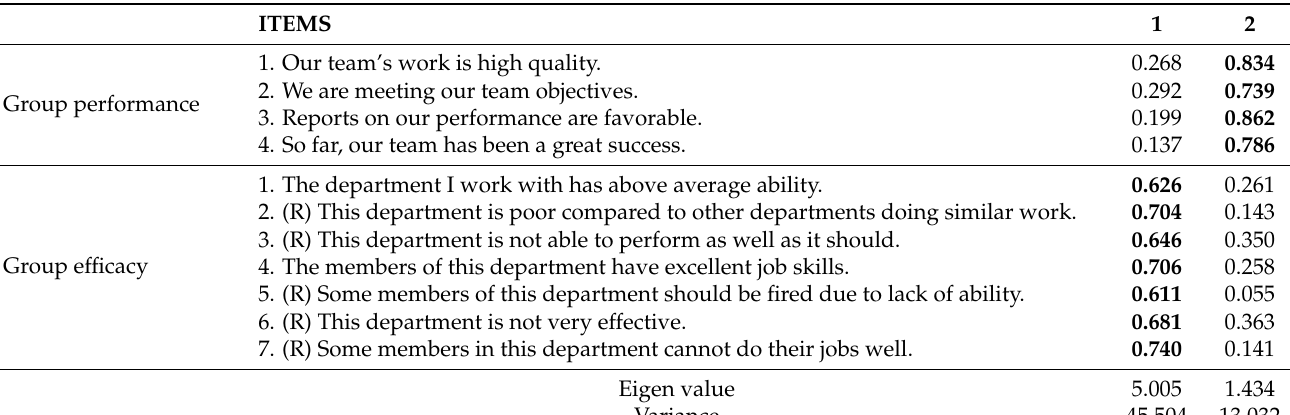
Table A1. Survey Items for Group Efficacy and Group Performance and Factor Analysis